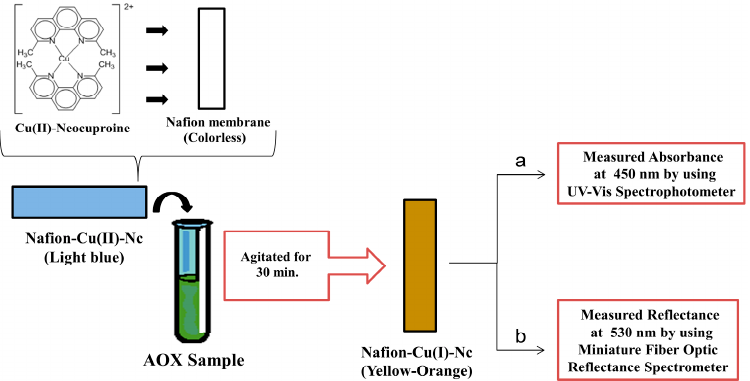
Figure 2. Schematic diagram of CUPRAC antioxidant sensors: the measurement of the analytical signal ( a ) for absorptimetric sensor and ( b ) for reflectometric sensor. Optical sensor based CUPRAC methods were validated through linearity, additivity, precision, expressed as the relative standard deviation (RSD, %) in absorptimetric and reflectometric modes of